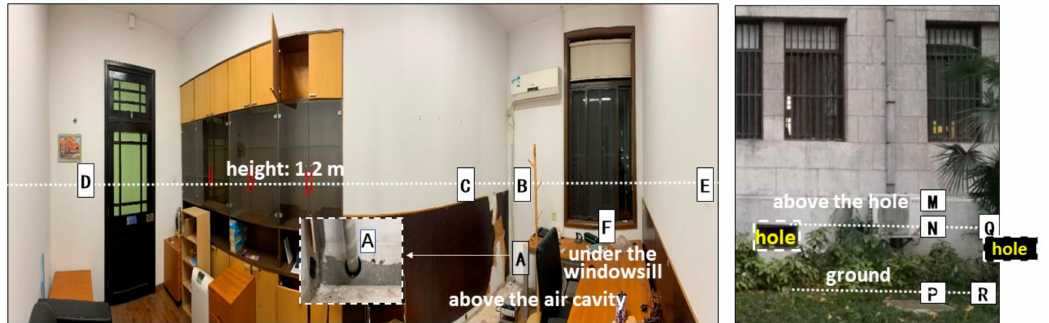
Figure 6. Surface water content measuring points (July and August